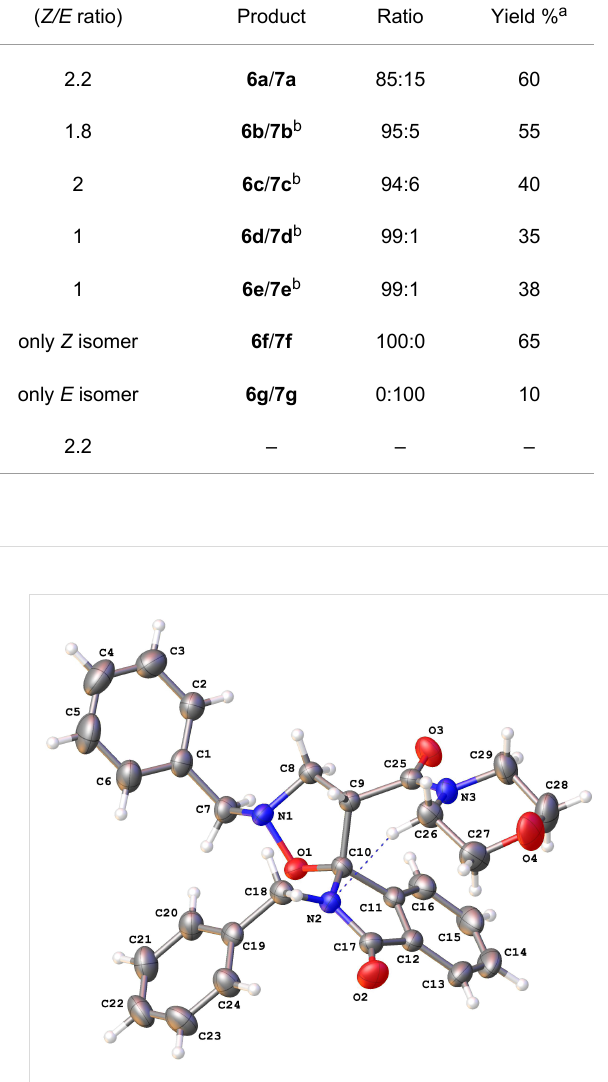
Figure 4: ORTEP drawing of the X-ray crystal structure of 7a showing the model atomic numbering scheme (C10 and C9 correspond to the chiral centres C1 and C4’, respectively). Crystal packing is a racemate due to the centrosymmetric symmetry and in the picture the choice of the enantiomer is arbitrary. C: light blue, H: white, O: red, N: magenta. Probability of the ORTEP ellipsoids is set to 50%, whereas H size is